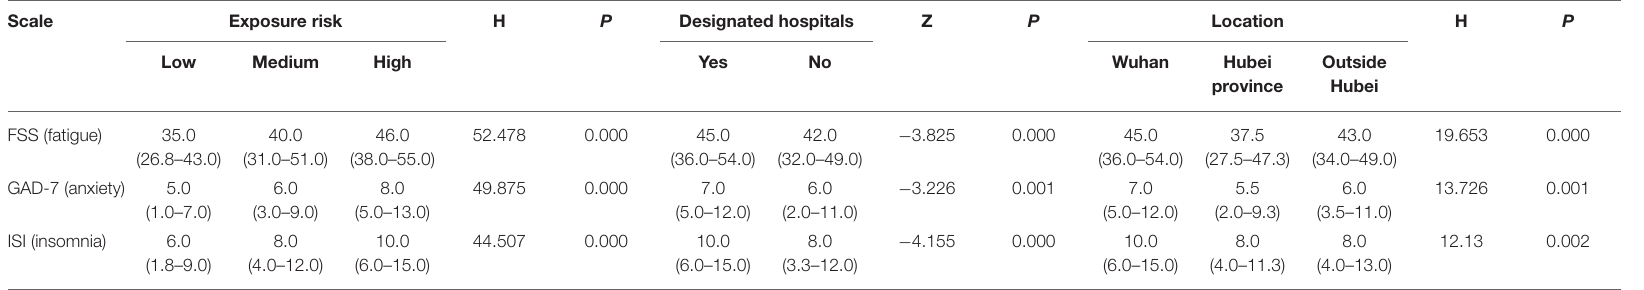
TABLE 3.2 | Scores of fatigue, anxiety, and insomnia measurements in subgroups.